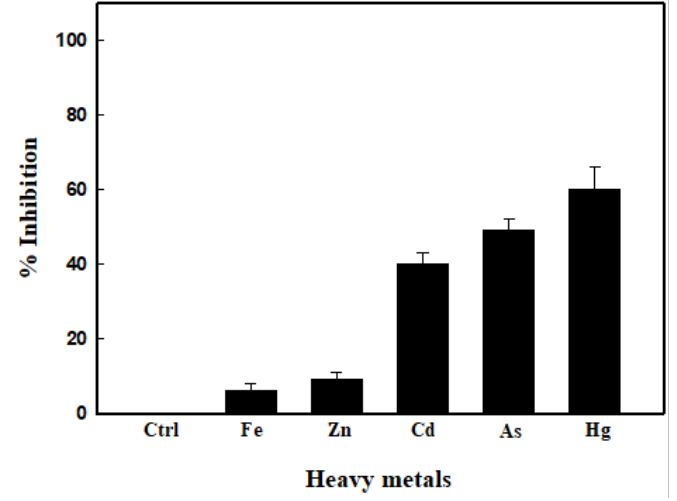
32 − reduction by heavy